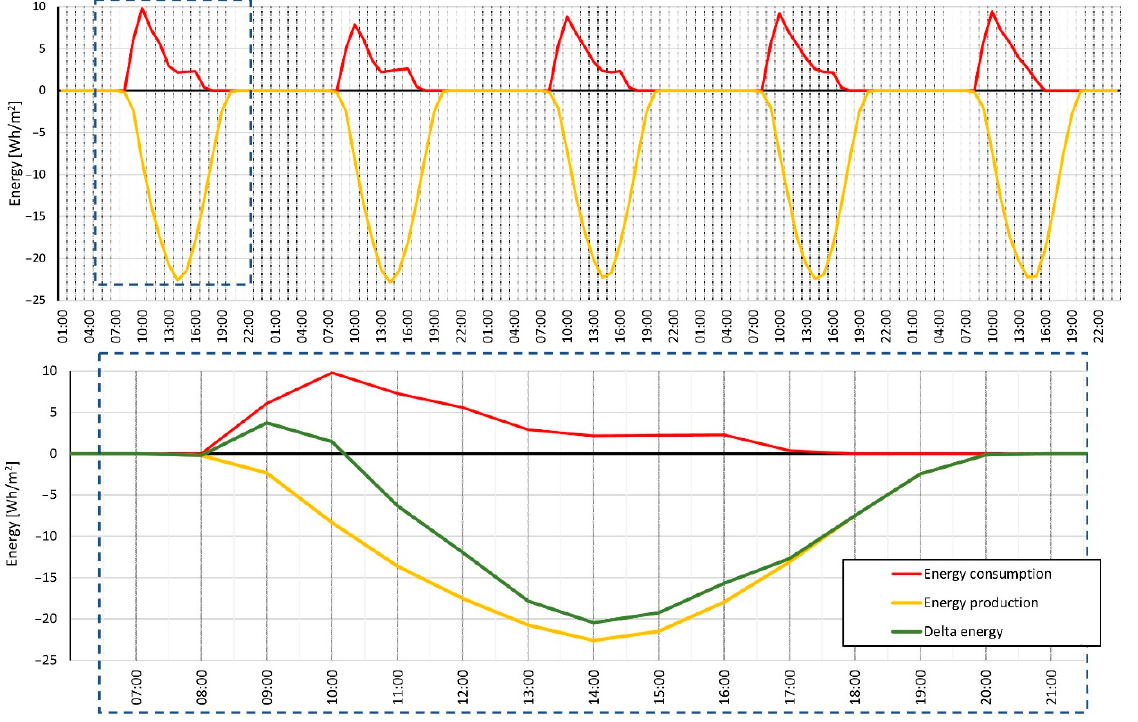
Figure 16. Hourly energy consumption of the building (red), PV energy production (yellow), and the difference between them (green) for a school week in March (14th–18th) and on the bottom the enlargement of the first day of the week is presented to stress the amount of the electrical energy from the public grid. The simultaneity of needs and PV production can be seen.